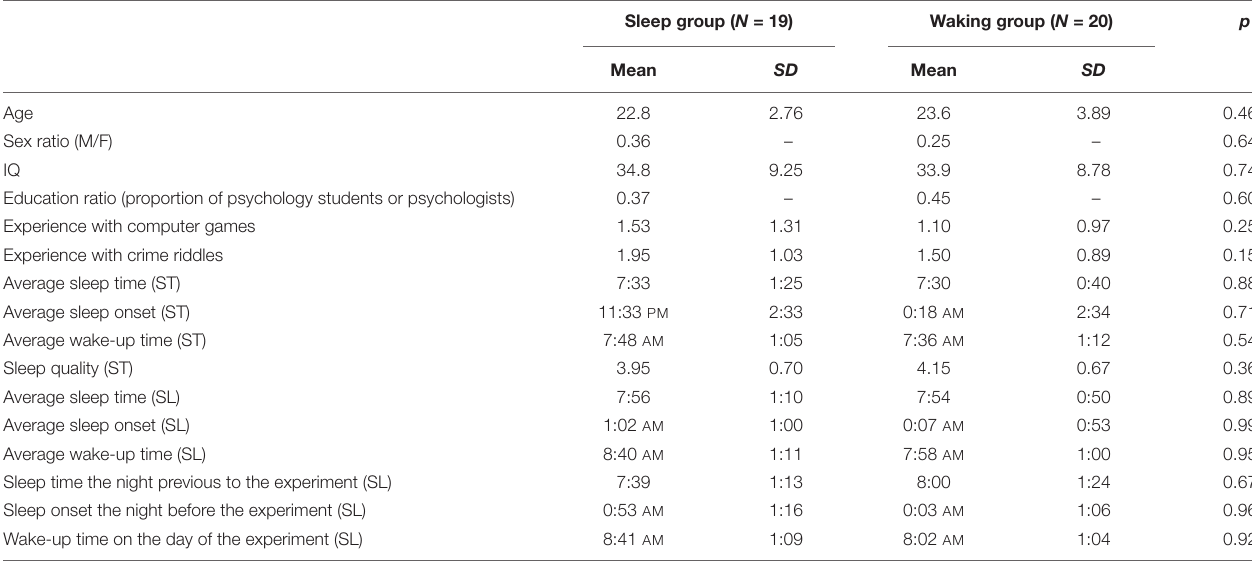
TABLE 4 | Sample demographics and sleep